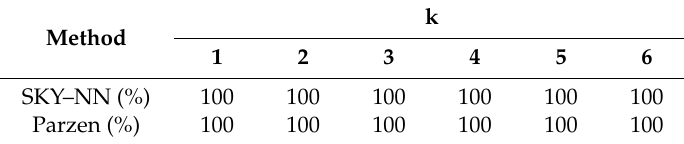
Table 14. Opposite skyline on the synthetic Dataset II.